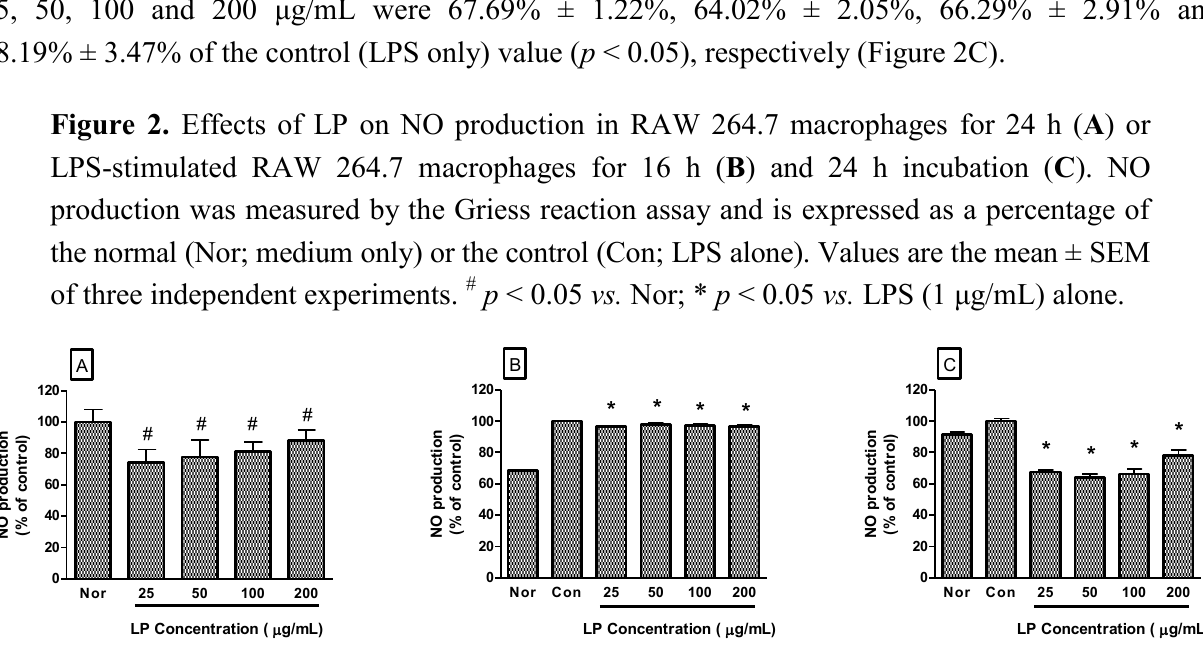
The effects of LP on production of cytokines in LPS-activated RAW 264.7 cells are shown in Figure 3. RAW 264.7 cells were treated with various concentrations of LP (25, 50, 100 and 200 μg/mL) and LPS for 24 h. LP significantly decreased the production of IL-6, IL-10, IL-12p40, IP-10, KC, VEGF, MCP-1, GM-CSF and PDGF-BB in LPS-activated mouse macrophages ( p < 0.05 vs. LPS